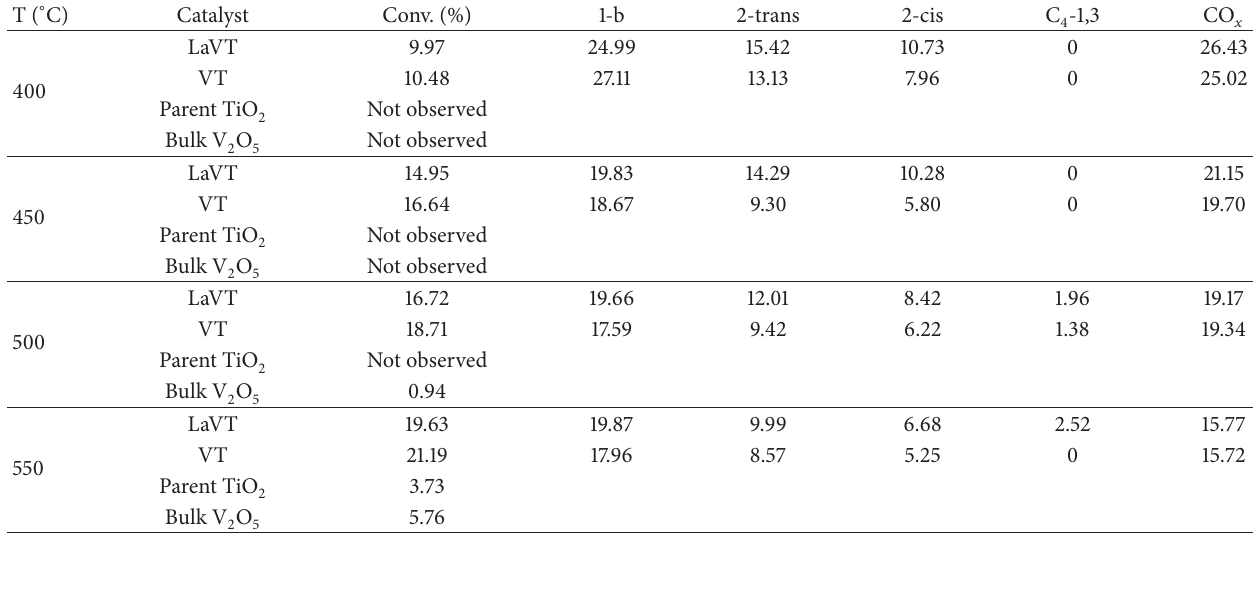
H /O /N = 30/10/60 vol. %, total flow rate 32 mL/min). 4 10 2 2